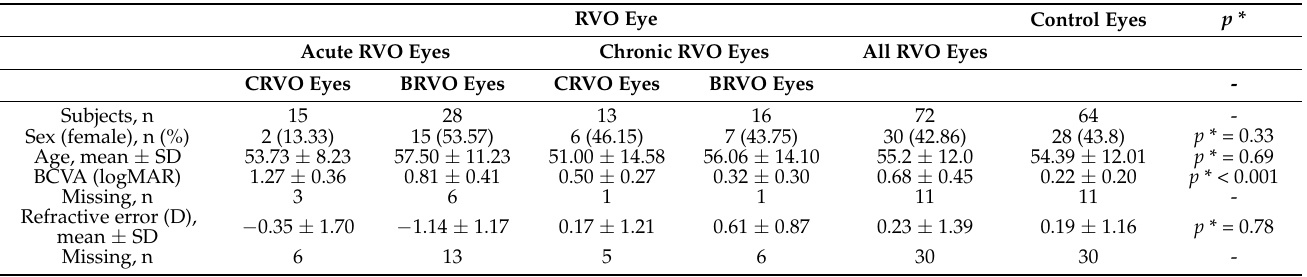
Table 1. Demographic characteristics of subjects.